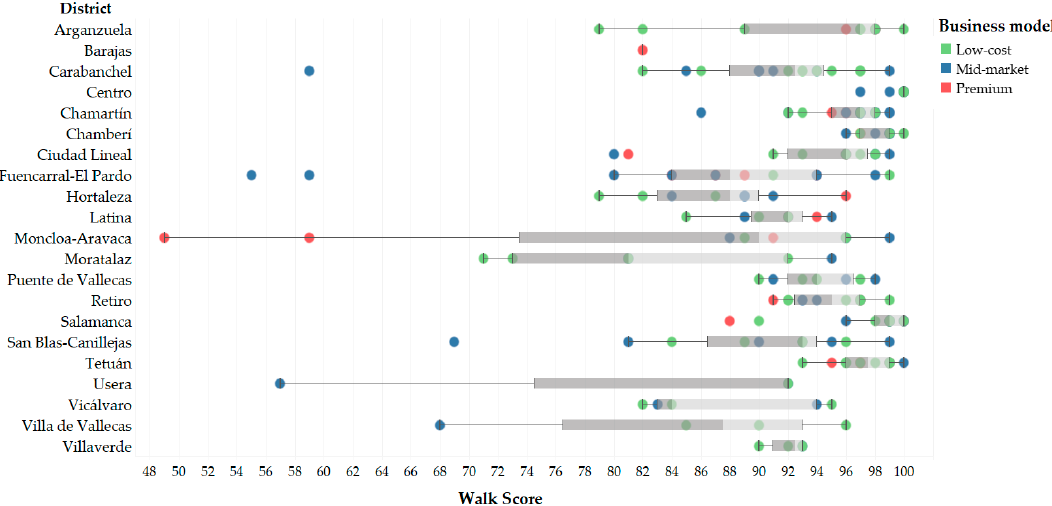
Figure 3. Fitness centers’ distribution by district.